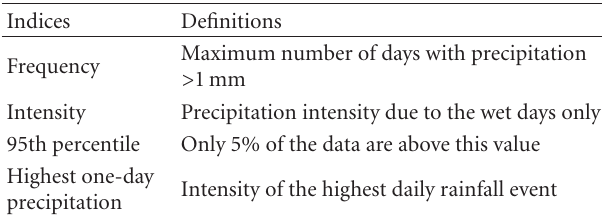
Table 1: Definition of